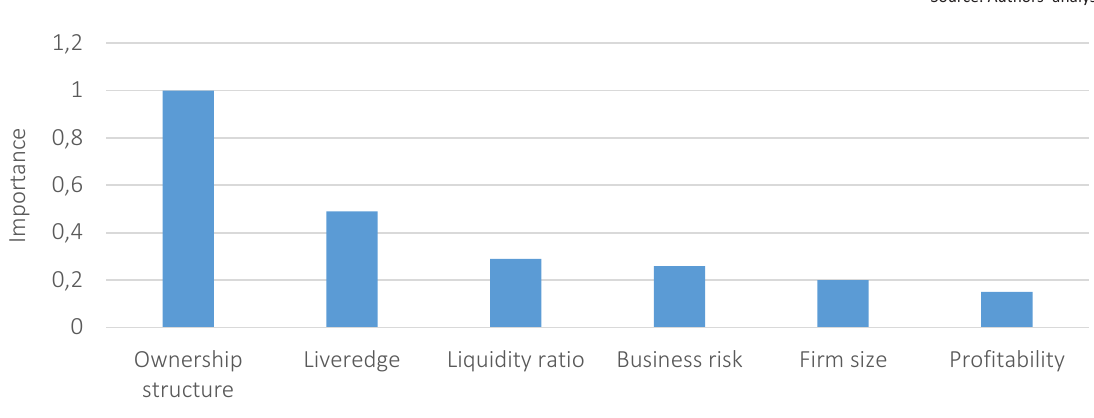
Figure 1. Comparison of equity and debt financing in 2014-2018